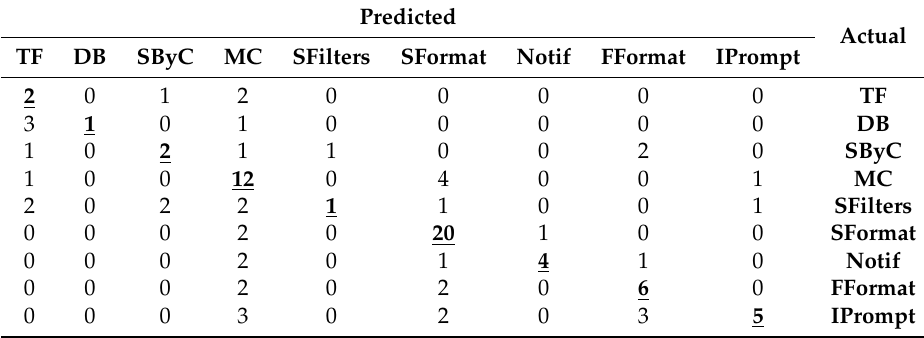
Table 4. Confusion matrix of LinearSVM algorithm in the requirements